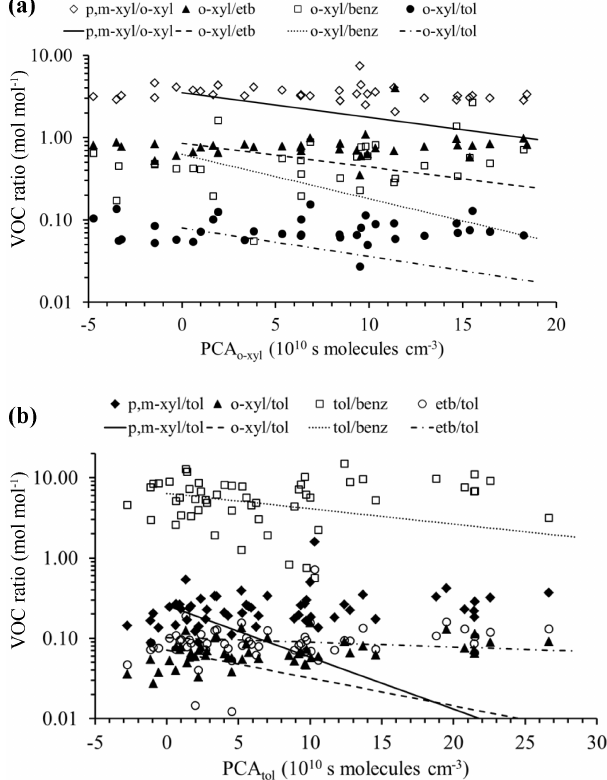
Figure 8. Plot of VOC concentration ratios vs. R [OH]d t (PCA) de- termined from carbon isotope ratios. The lines show the change in carbon isotope ratios predicted for identical R [OH]d t of the differ- ent